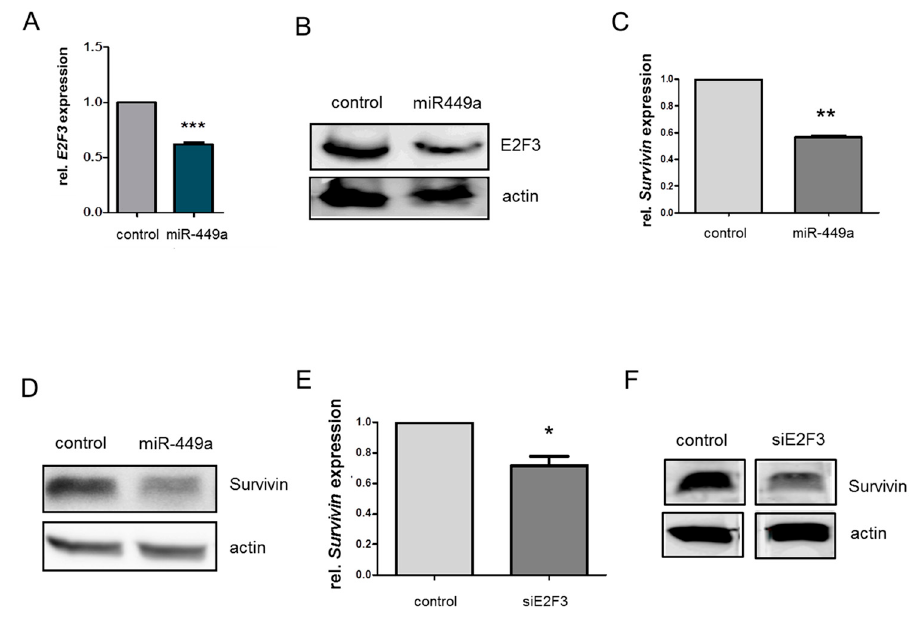
Figure 3. MiR-449a decreases expression of Survivin indirectly by targeting E2F3. ( A ) Expression of E2F3 mRNA measured by RT-PCR 48 h after transfection with miR-449a-mimics or control. ( B ) Ex- pression of E2F3 protein using Western blotting in HCC38 cells. Actin was used as a loading control on the same blot but on a different part of the gel. ( C ) Expression of Survivin mRNA measured by RT-PCR 48 h after transfection with miR-449a-mimics or control on mRNA level. ( D ) Expression of Survivin protein using Western blot in HCC38 cells. Actin was used as a loading control on the same blot but on a different part of the gel. ( E ) Expression of Survivin mRNA measured by RT-PCR 48 h after transfection with siE2F3 or si-control. ( F ) Expression of Survivin protein using Western blot in HCC38 cells after transfection with siE2F3 or si-control. Actin was used as a loading control on the same blot but on a different part of the gel. Error bars represent SEM. N = 3. * p < 0.05, ** p < 0.01, *** p < 0.001, 2-tailed Student’s t -test.